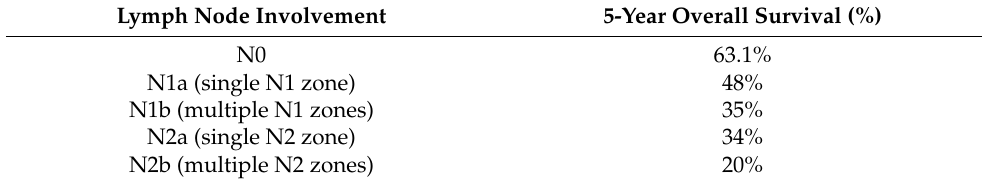
Table 1. N1 and N2 involvement in OS.